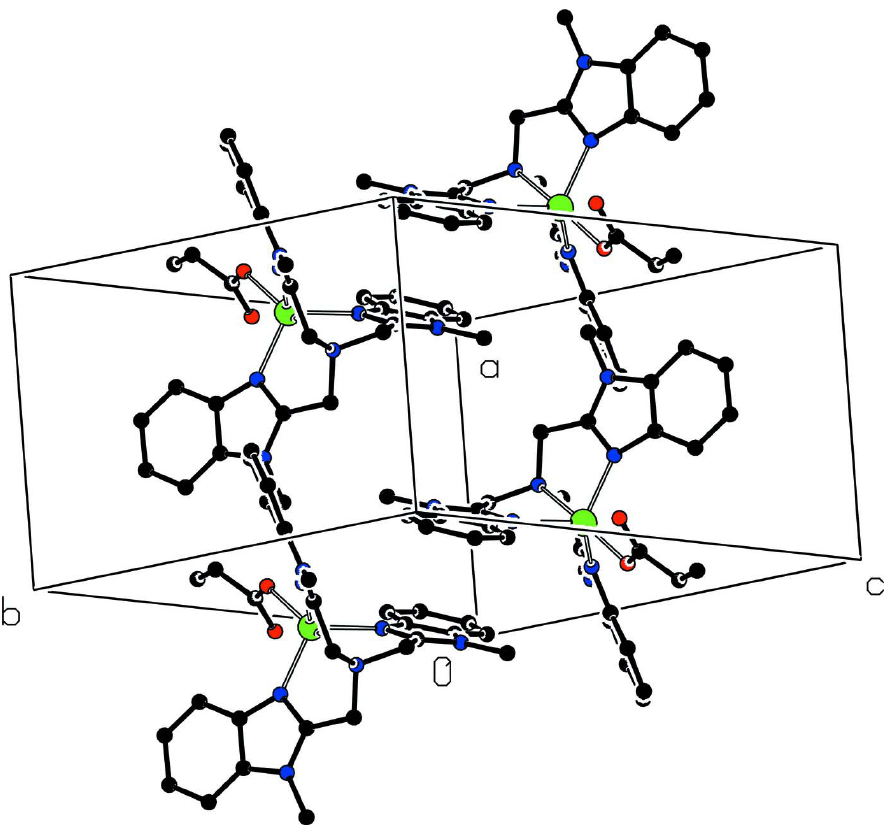
The packing of the cations. Neither the disorder or H atoms are